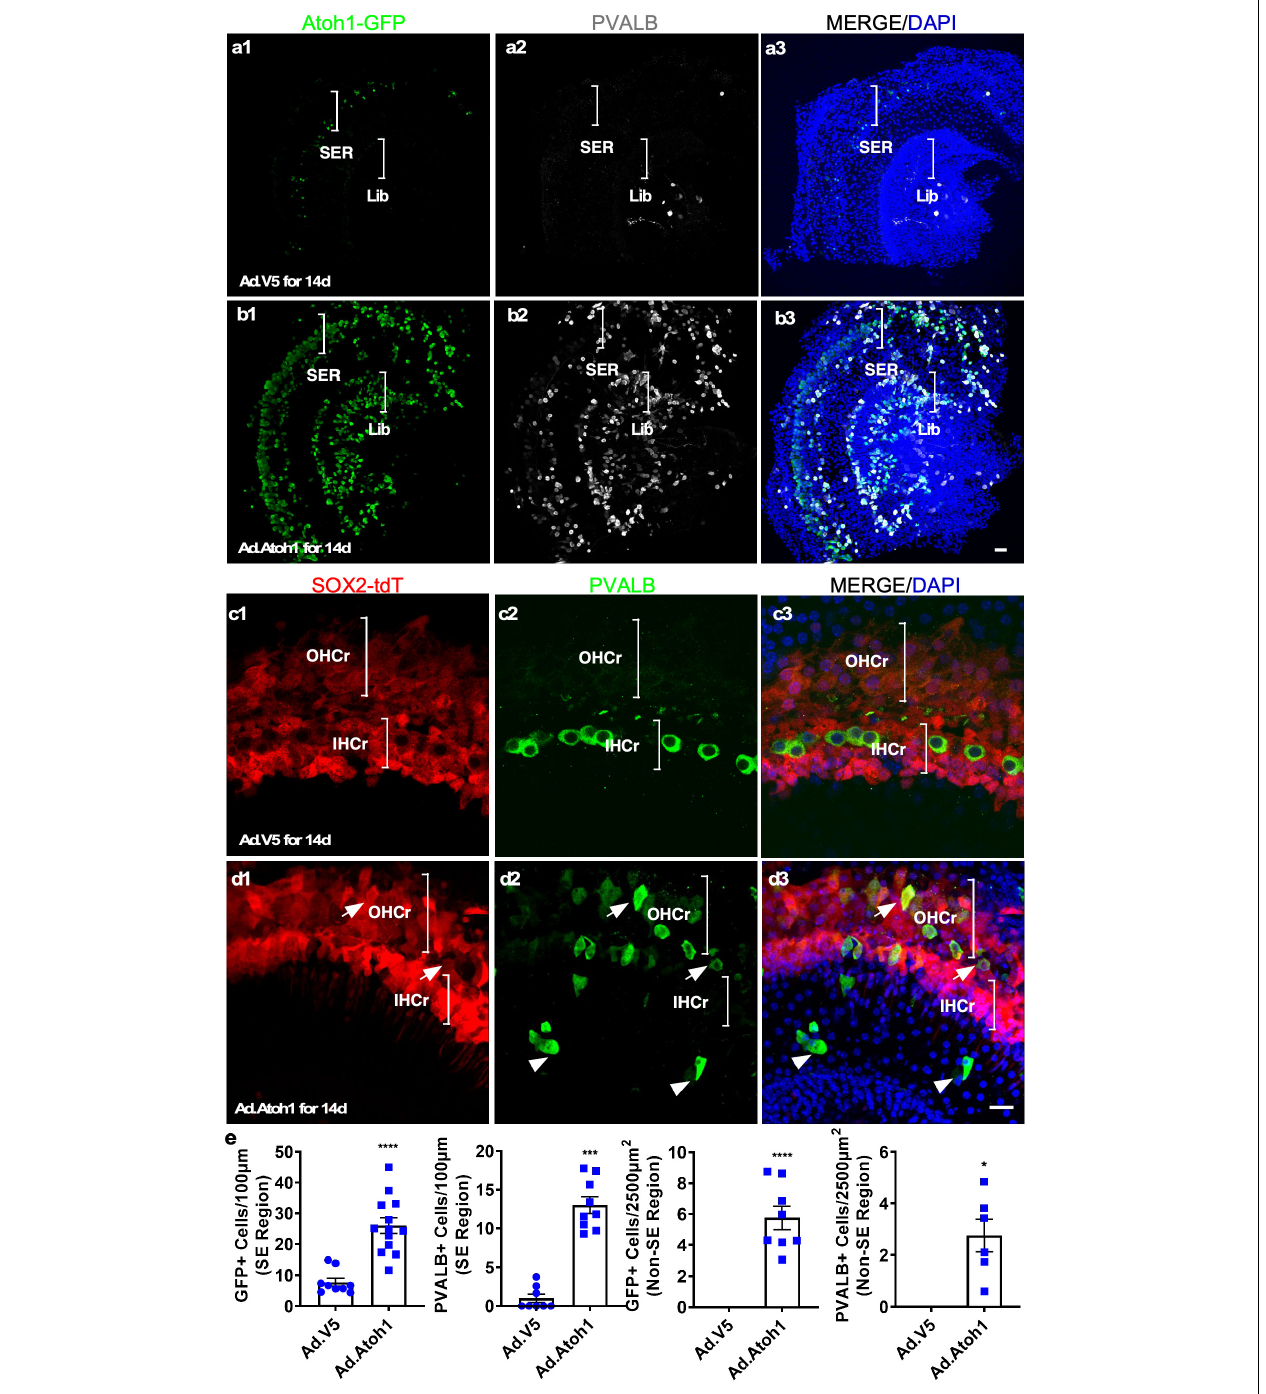
FIGURE 5 | Transdifferentiation of Ad-Atoh1-infected cells and lineage tracing in cultured adult cochleae. (a1–a3) In cultured adult Atoh1-GFP cochleae (apex), control Ad-V5 infection-induced only a few GFP + cells in the SER (bracket). There was no induction of GFP in the limbus region (Lib, bracket). (b1–b3) In cultured adult Atoh1-GFP cochleae (apex), Ad-Atoh1 infection-induced many GFP + cells in the SER (bracket) and Lib (bracket). (c,d) SC origin of regenerated HC-like cells (HCLCs) by lineage tracing. (c1–c3) In the apex of the cultured adult Sox2-CreER-Tm-red cochleae infected with Ad-V5, no PVALB + cells were detected in the OHC region whereas the surviving IHCs were Tm-red negative. (d1–d3) HCLCs (PVALB + ) were detected in the OHC region that was co-localized with Tm-red signal (arrows) as well as in the non-sensory region (arrowheads) that were devoid of Tm-red after Ad-Atoh1 infection in cultured adult Sox2-CreER-Tm-red cochleae. (e) Quantification of GFP+ cells and new HCLCs from apex, apex-mid, and base in Ad-V5 and Ad-Atoh1 groups. * p < 0.05, *** p < 0.001, **** p < 0.0001, Student’s t -test. Error bar, mean ± SEM, n = 3–13. n is the number of biologically independent cochlea samples. Scale bars: 20 µ m.